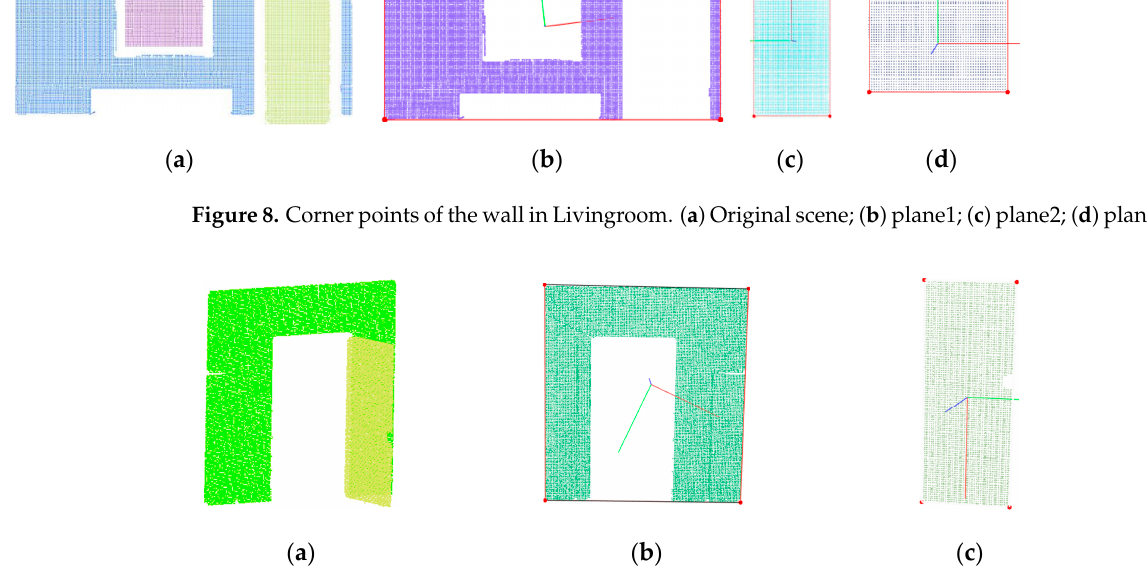
Figure 9. Corner points of the wall in House. ( a ) Original scene; ( b ) plane1; ( c ) plane2.